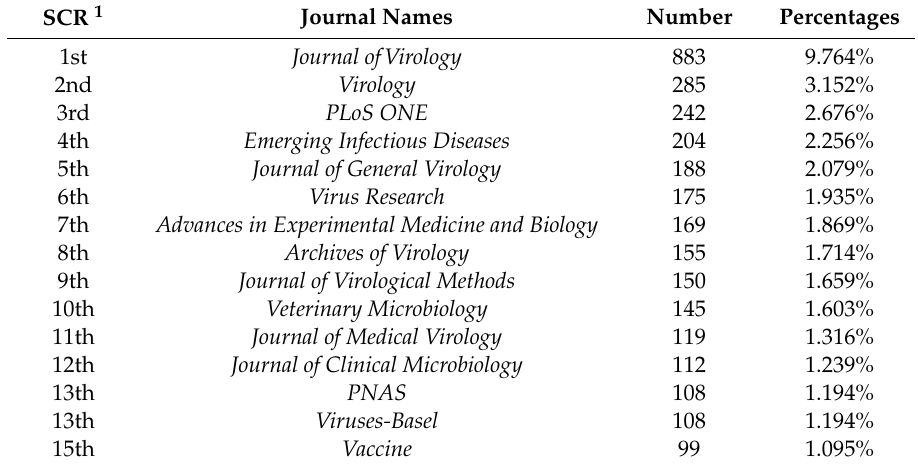
Table 2. The 15 most productive journals with coronavirus